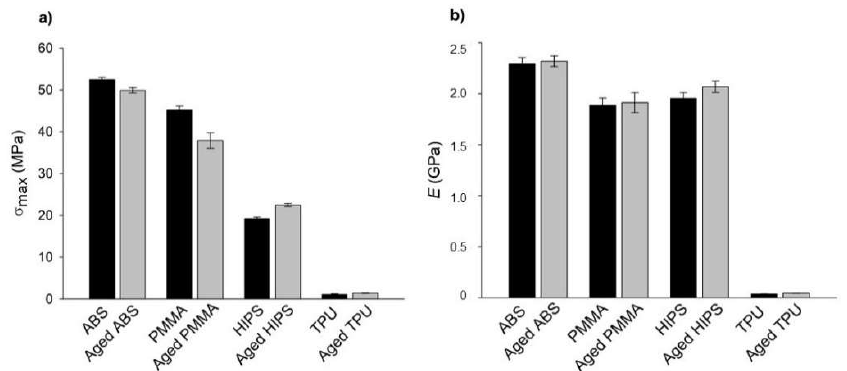
Figure 2. Stress–displacement curves that were obtained from the 3PB tests of the mono-materials.